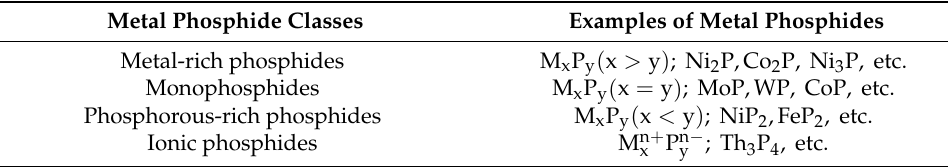
Table 2. physical properties of metal-rich phosphides.